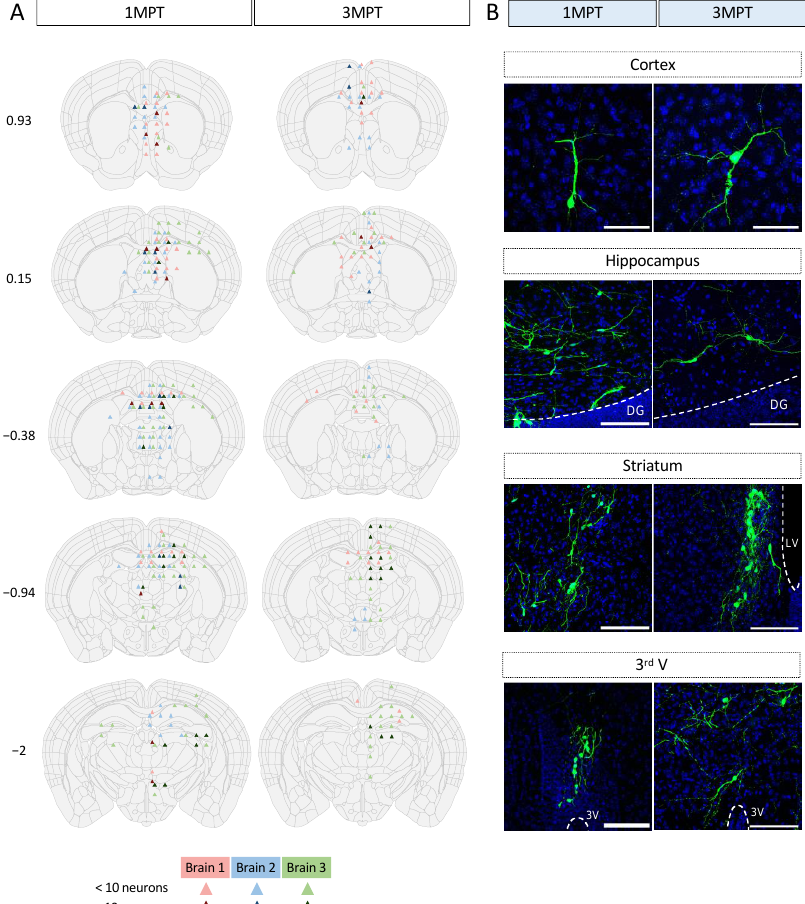
Figure 4. Mapping of neuronal somas from transplanted human cells within the LV of the embryonic mouse brain at 1 MPT and 3 MPT. ( A ) Camera lucida drawings are according to Allen Brain Atlas (https://mouse.brain-map.org/, accessed on 25 January 2023). Image credit: Allen Institute. Two brain sections were analyzed for each coordinate (Bregma, indicated in mm) and per mouse. Each brain analyzed is represented in a different color and the number of neuronal somas is represented in a color-code manner. For each brain and coordinate, 40-µm thick images were used and the counted values summed. ( B ) Representative images of brain regions where the grafted human cells tended to migrate.